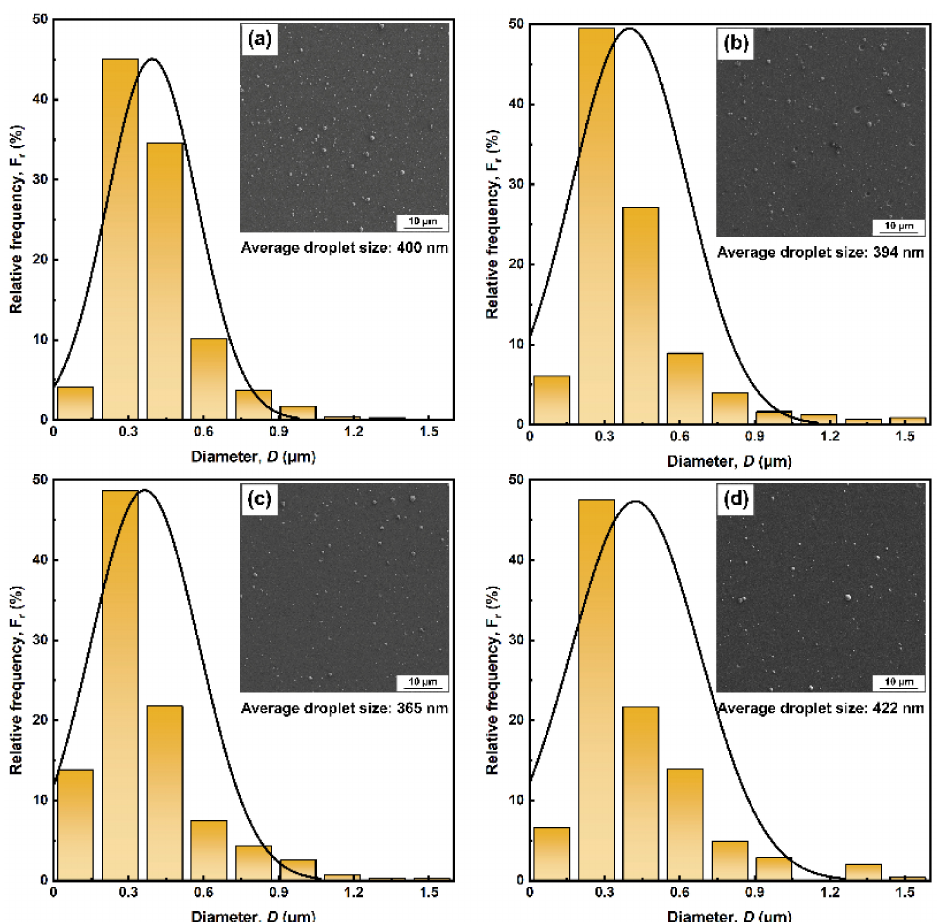
Figure 4. The surface SEM micrograph of the Cr 2 N/TiN multilayer coatings and its particle size distribution histogram. ( a ) − 30 V, ( b ) − 60 V, ( c ) − 100 V, and ( d ) − 150